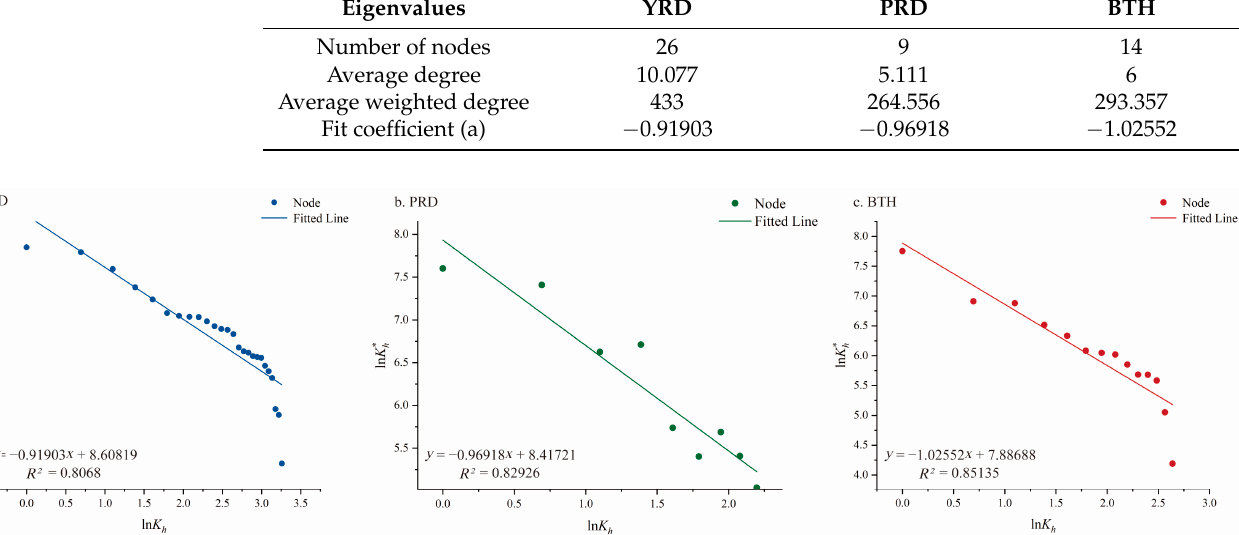
Figure 4. Fitting results of the weighted degree distribution of check flow network of three major urban agglomerations.